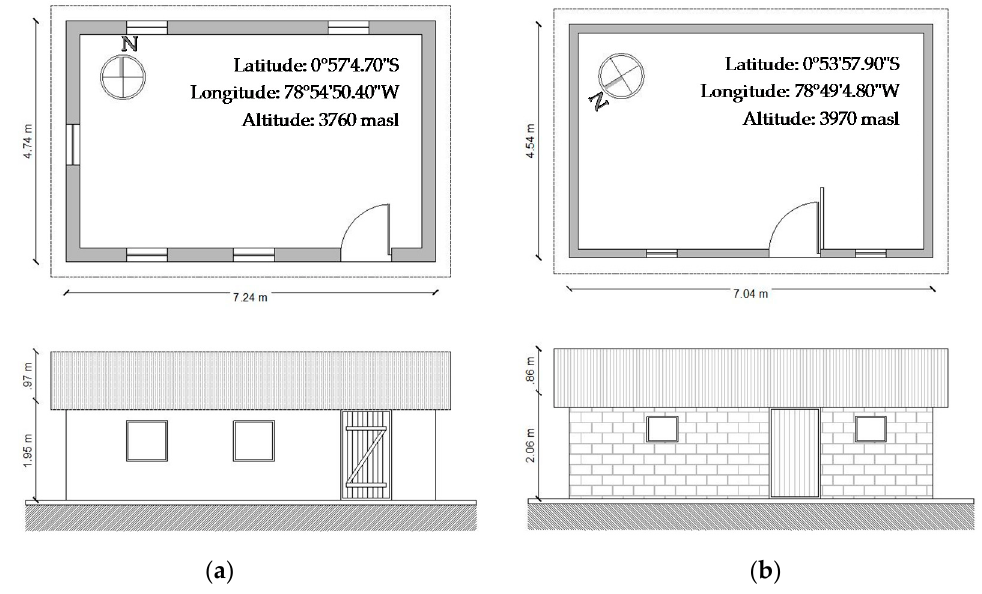
Figure 1. Schema of the dwellings locations and dimension. ( a ) Case A; and ( b ) Case B.